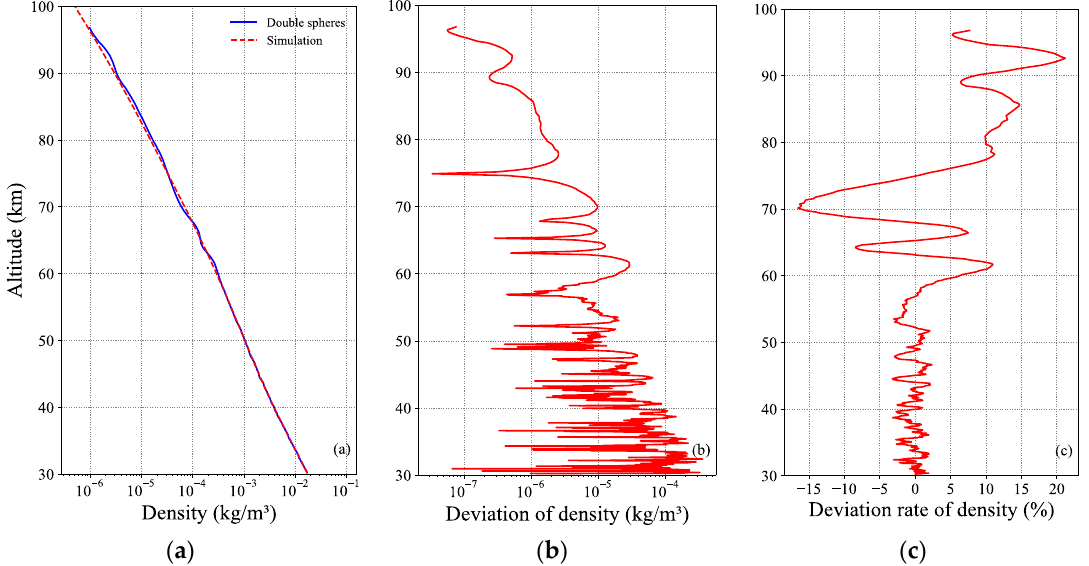
Figure 8. Inversion result of the atmospheric density profile. ( a ) Comparison of the retrieved atmospheric density profile with the simulated atmospheric density profile; ( b ) deviation of the density (the absolute value of the difference between the retrieved density and the simulated density); ( c ) Deviation rate of the density (the ratio between the deviation of the density and the simulated density).